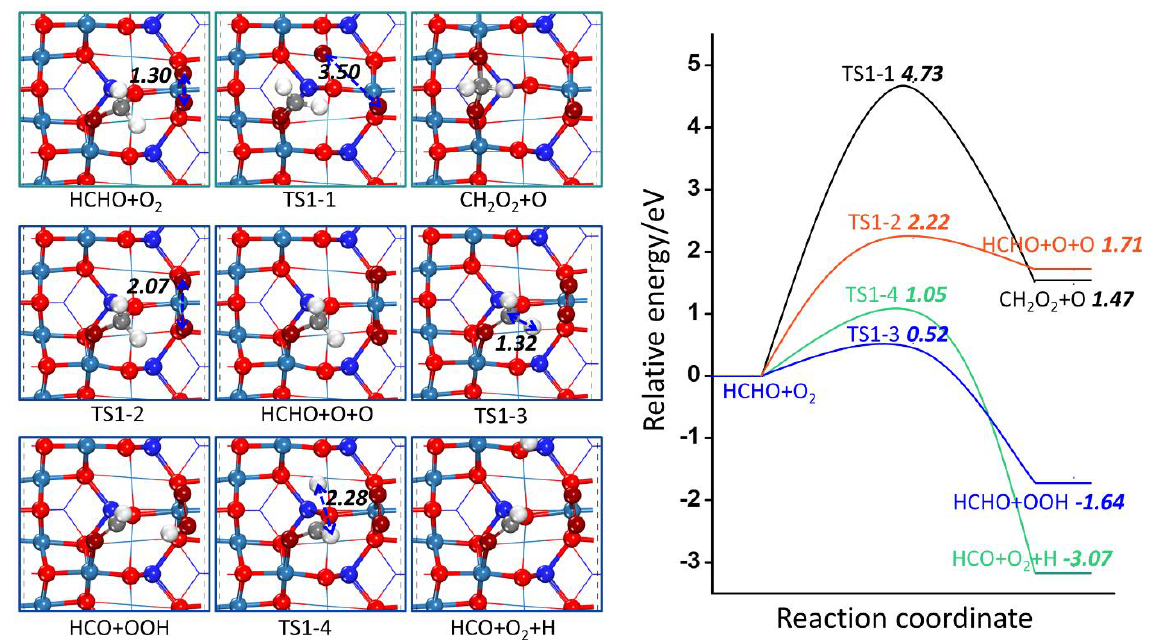
Figure 4. The potential energy profile of the first step of HCHO oxidation together with the structures of TSs and FSs on Co 3 O 4 (110) surface. The unit of bond lengths are Å. R1-1 goes through TS1-1 to form CH 2 O 2 and O. Firstly, HCHO adsorbs at hollow site, and O 2 adsorbs on the top Co 3+ site with the O – O bond length of 1.31 Å. Then, one O atom tends to get close to the C atom of HCHO with the O – O distance extending to 3.50 Å. In